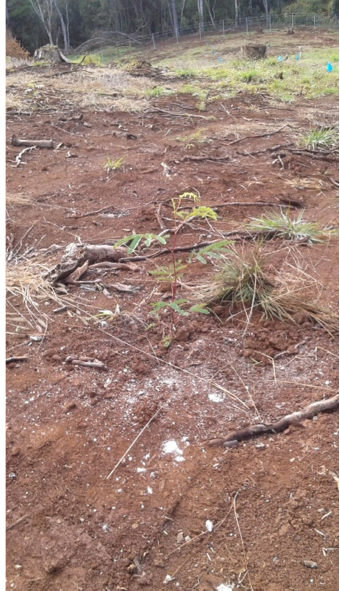
Figure A1. Recently planted koa seedling at the Kokee site.